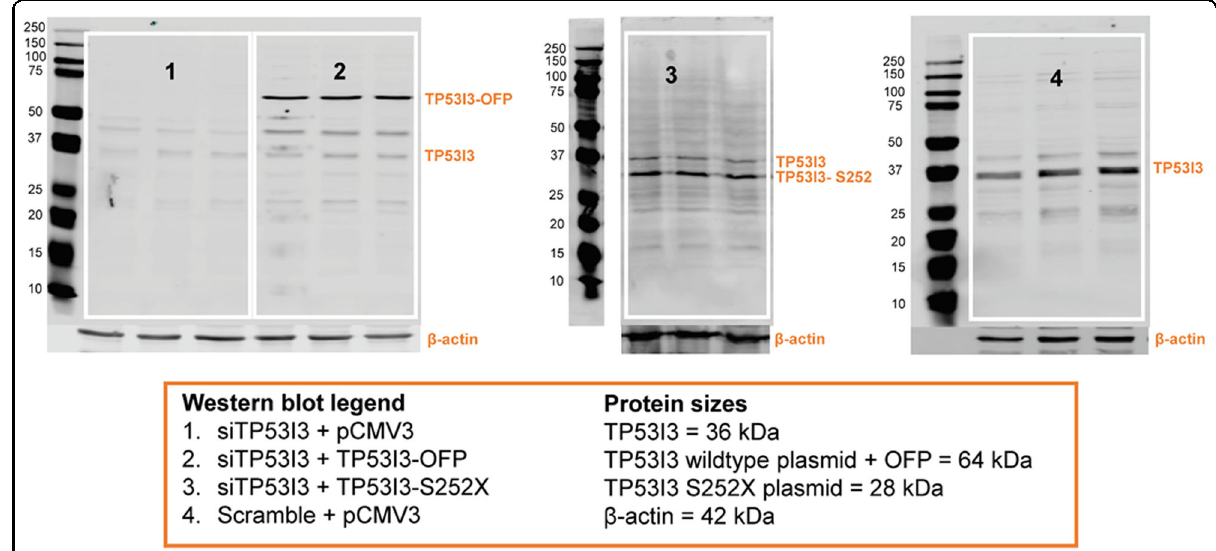
Fig. 3 TP53I3 rescue with wildtype and TP53I3-S252X mutant plasmids. For TP53I3 wildtype and mutant expression, HeLa-DR-GFP cells were plated in 60 mm plates with 2 mL of growth media and treated with a transfection complex in parallel with each homologous recombination repair assay. The complex contained 525 pmole TP53I3/scramble siRNA, 5 ng/µL TP53I3 wildtype/TP53I3-S252X/pCMV3 plasmids, 150 µL jetPrime© Buffer, and 9 µL of jetPrime© transfection reagent. TP53I3 was successfully rescued after siRNA knockdown (1) with the TP53I3 wildtype plasmid (2). The wildtype plasmid contains an orange fl uorescence protein (OFP) at the C-terminus. TP53I3-S252X mutant expression (3) was successful after transfection into TP53I3-de fi cient cells. The immunoblot for TP53I3-S252X expression and the markers are from the same gel, with three lanes removed owing to loss of cell lysates volume. At last, endogenous TP53I3 expression was also determined after cells were given Scramble siRNA and the empty plasmid vector pCMV3 (4). Each condition was completed in triplicate to ensure consistency and ef fi ciency of